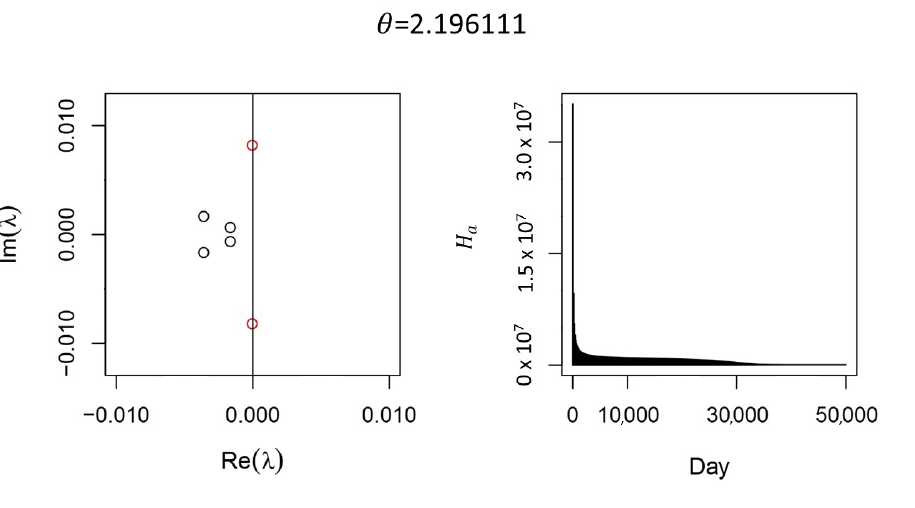
Figure A3. Supercritical Hopf Bifurcation in the Full Model. The red complex eigenpair is about to cross the imaginary axis as θ passes near 2.2, resulting in a supercritical Hopf bifurcation (left). Two real eigenvalues near − 0.1 are not shown. Near the bifurcation, transients decay slowly (right). These results were generated from the full model without calibrating to data, without vaccination, ν k = 1/2, Q ah = 0, Q al = Q kl = Q kh = (cid:103) Q ah = (cid:103) Q al = (cid:103) Q kl = (cid:103) Q kh = 1, and contact rates α aa = α ak = α kk = α were chosen so R 0 = 2.5. For simplicity, we have set τ = µ = 0. Hopf bifurcations are only present close the limiting case Q ah = 0, Q al = Q kl = Q kh = (cid:103) Q ah = (cid:103) Q al = (cid:103) Q kl = (cid:103) Q kh =